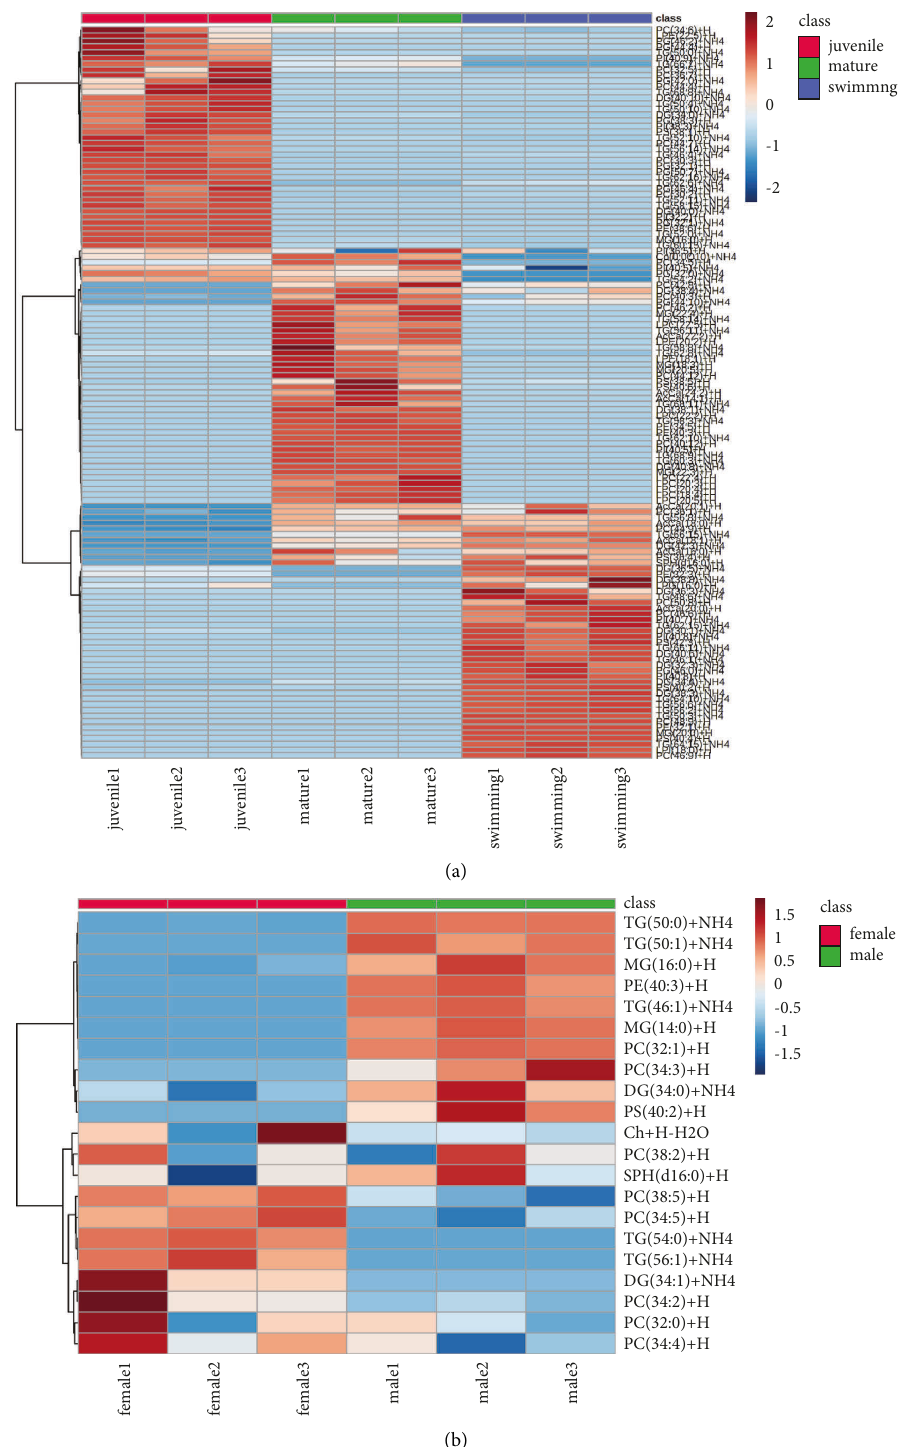
Figure 4: Heatmap showing the relative amounts of lipids in (a) abalone tissues at three different developmental stages (swimming veliger larvae, juveniles, and mature individuals) and (b) the hemolymph of female and male Among the 132 lipids, the VIP score plot of the top 10 cluster, and each group was clearly separated, indicating lipids selected based on the PLS-DA model is shown in distinct differences in lipid profiles among the groups. In the Figure 3(c). Seven lipids, namely PC (36 :1), TG (46 :1), TG PLS-DA score plot, components 1 and 2 explained, re- (56 : 6) PC (34 : 5), TG (56 : 8), TG (50 : 3), and DG (34 : 0), spectively, 51% and 44% of the total variance.